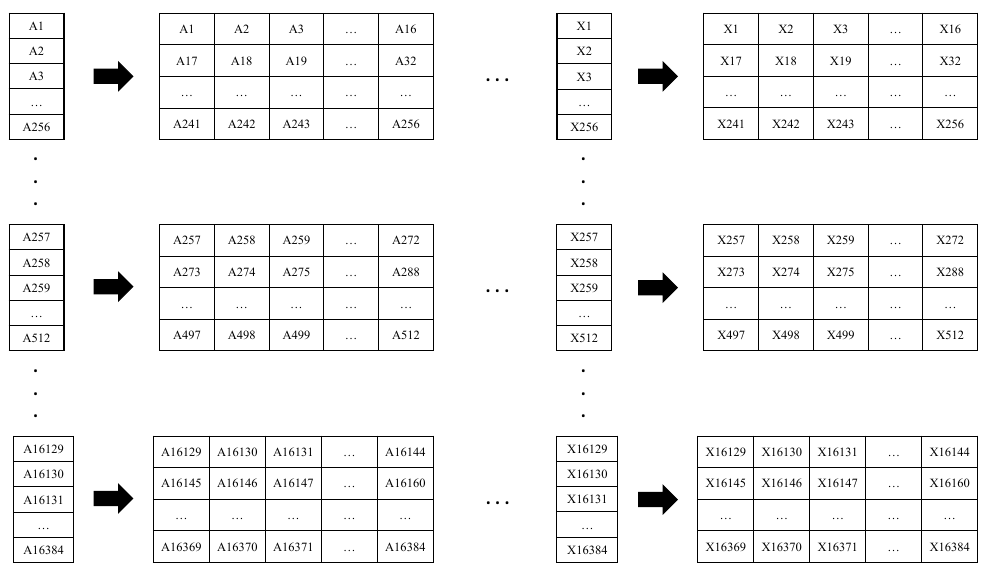
Figure 6. Reshape of the 256 values into 16 × 16 size matrices. The last 132 values from each column were not considered because they could not complete the 256 values required to build a (16 × 16) matrix. Once the two-dimensional matrices were obtained, the process was continued with the creation of the 16 × 16 × 24 size images. For each experiment, the first matrices formed by the 256 first values of their respective columns were time-related. Meaning that each value from a specific position on each matrix was sampled at the same time as the values occupying the same position on the rest of the 23 matrices. Basically, the first 24 matrices were grouped together to maintain this relation provided by this new feature. The same was applied to the second group of matrices, and so on and so forth, until 64 groups of matrices were obtained from each experiment (see Figure 7).